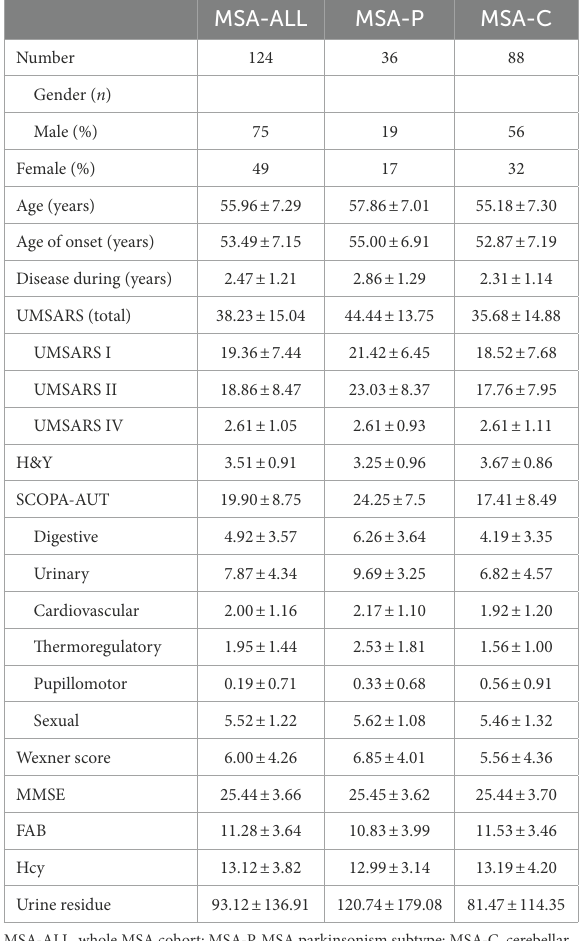
TABLE 2 Demographic, clinical parameters in MSA, MSA-P, and MSA-C